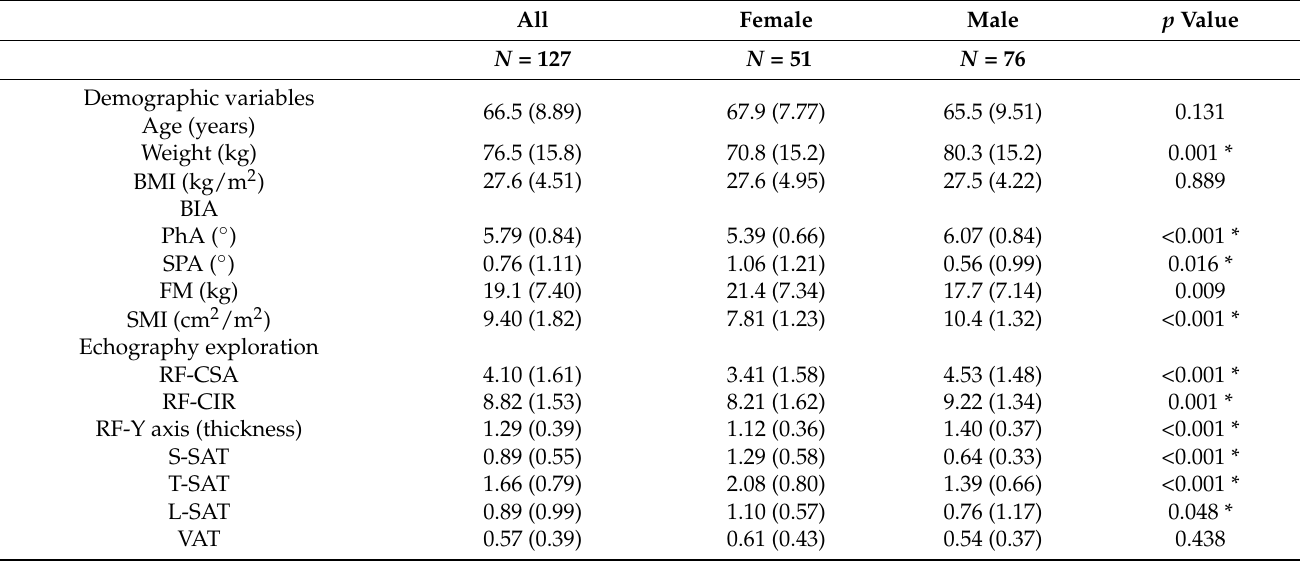
Table 1. Summary descriptive table grouped by